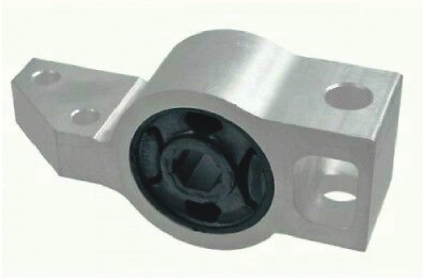
Figure 1: Silent block suspension system of a